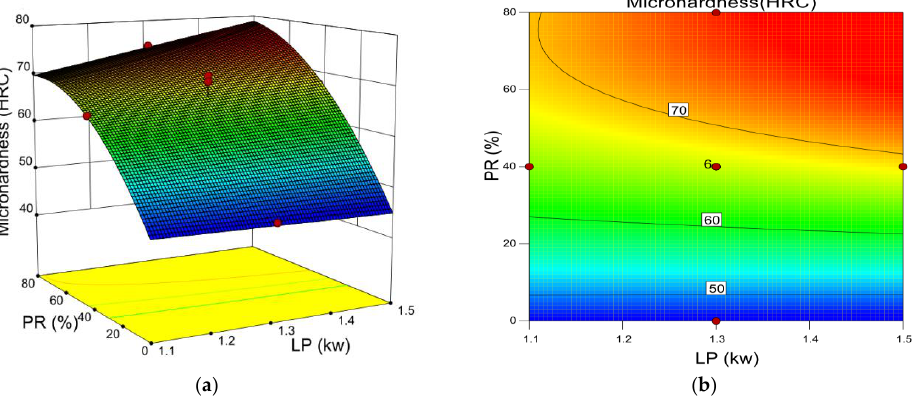
Figure 7. ( a ) 3D influence of laser power and TiC powder ratio on micro-hardness. ( b ) Contour line of laser power and TiC powder ratio on micro-hardness.